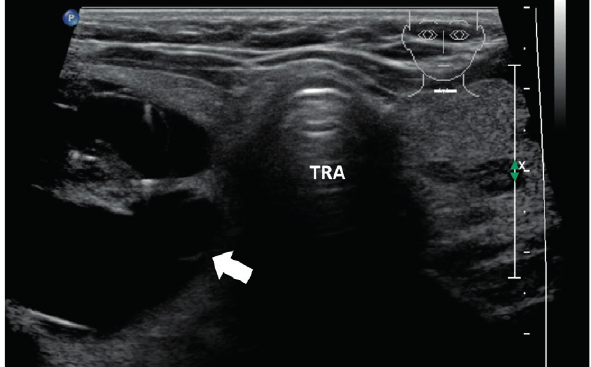
Fig. 2a. A 53–year–old woman with two years palpable resis- tance on the neck.